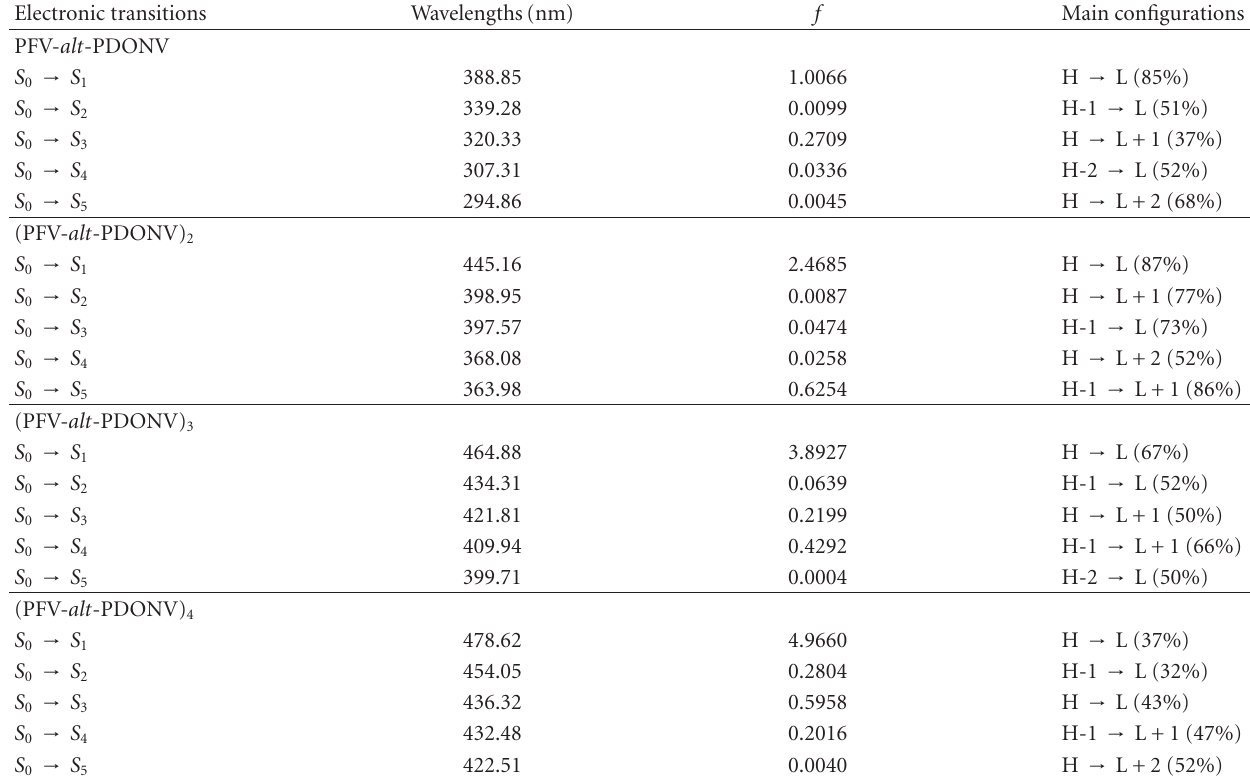
Table 4: Electronic transition data obtained by TDDFT method for PFV- alt -PDONV ( n = 1–4) at B3LYP/6-31G(d).